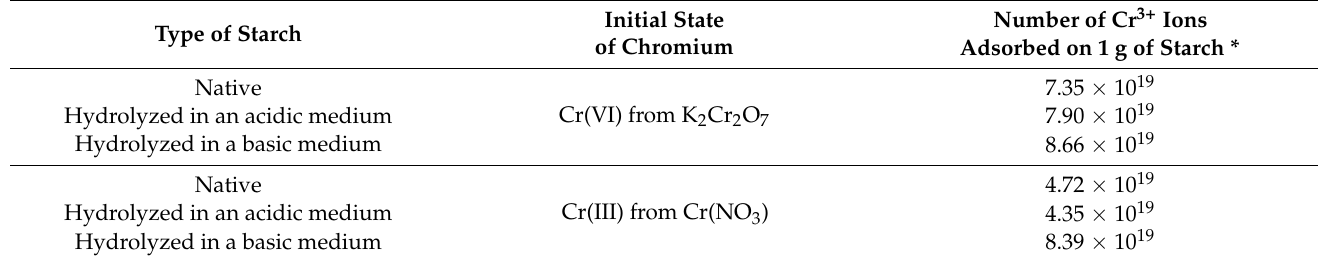
Table 2. Effect of contact of Cr(VI) and Cr(III) ions in aqueous solutions (pH = 1) with native and hydrolyzed potato starch. Conditions: concentration of Cr 5 g/L, 22.5 cm 3 of a solution, 5 g of starch, contact time 24 h, room